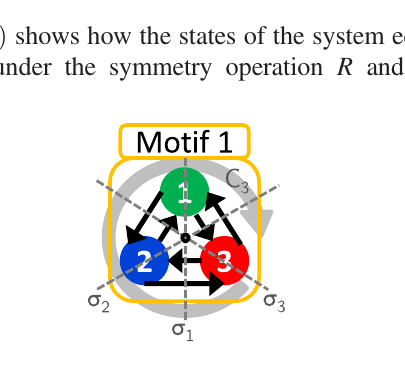
with n ¼ n 3 about an axis